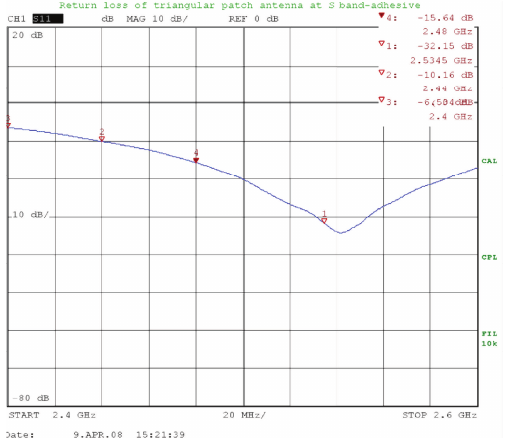
Figure 9: Measured retun loss using adhesive.